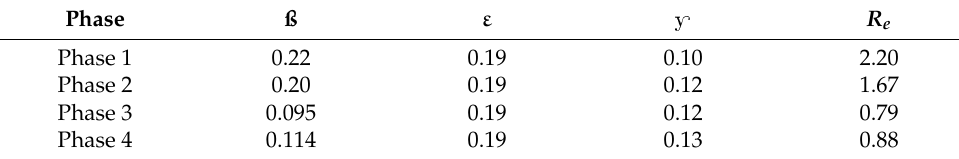
Table 1. Parameters in different